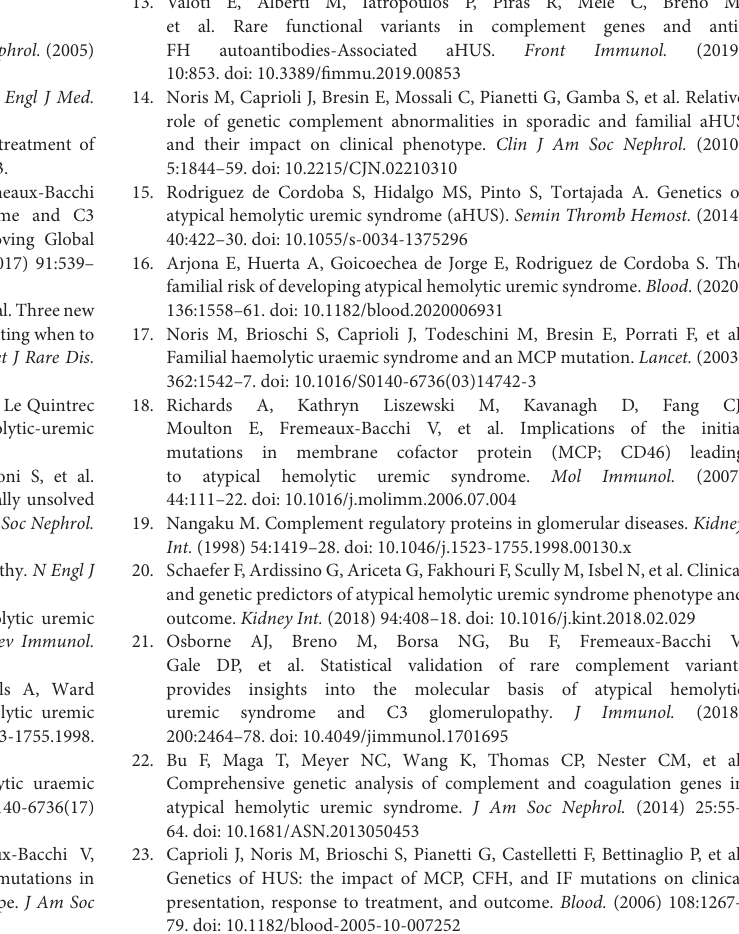
Supplementary Figure 1 | Gating strategy used to evaluate CD46 surface expression on lymphocytes by flow cytometry. Fresh or thawed PBMCs were labeled with anti-human CD3 antibody and with antibody anti-human CD46 FITC recognizing SCR1 epitope (A) or with antibody anti-human CD46 FITC recognizing SCR4 epitope (B)